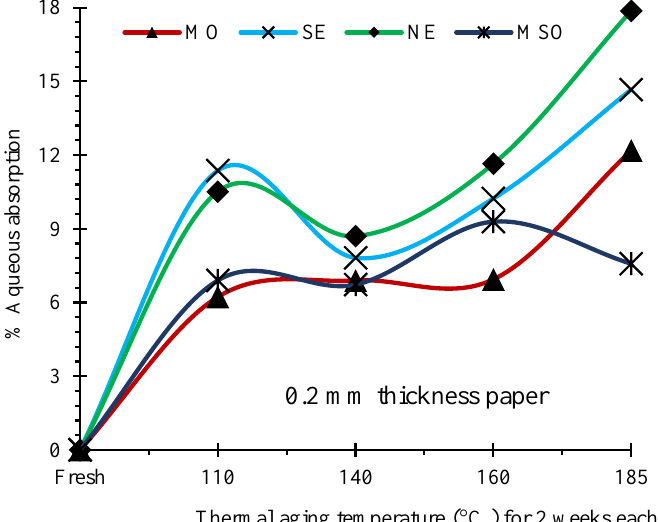
Figure 7. Wetting characteristics of 0.2 mm thickness papers with thermal stressing in various insulating oils.